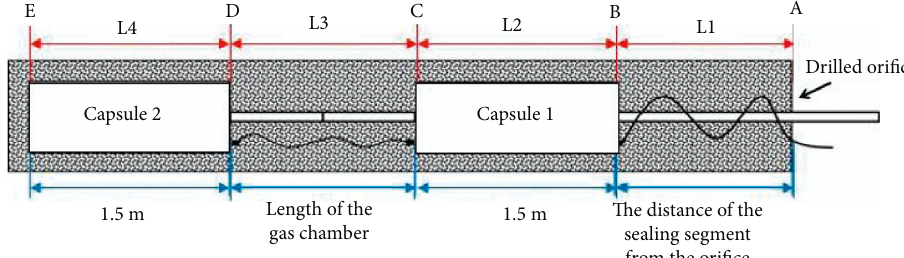
Figure 2: Schematic diagram of the calculation of the length of the sealing hole position.